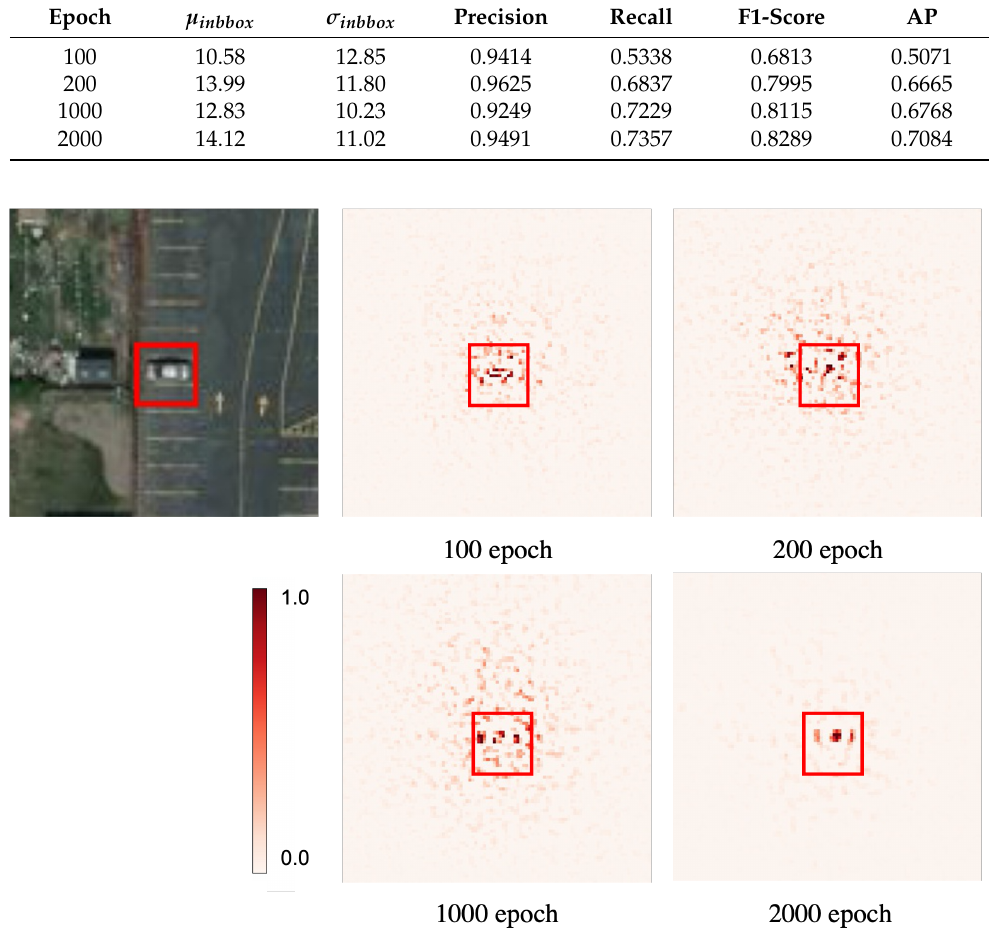
Figure 9. Visualization results of positive outputs by pixel-wise Gradient SHAP at each